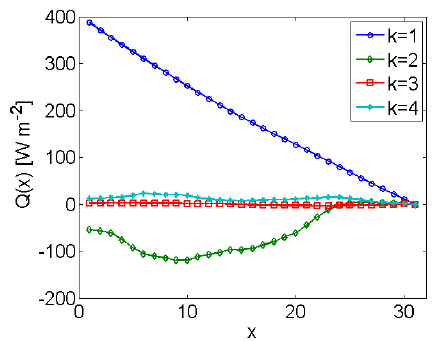
Figure 15. Averaged (in t and x ) profiles calculated from the origi- nal full temperature maps, for temperature (blue), heat flux (green), and negative temperature gradient (red).